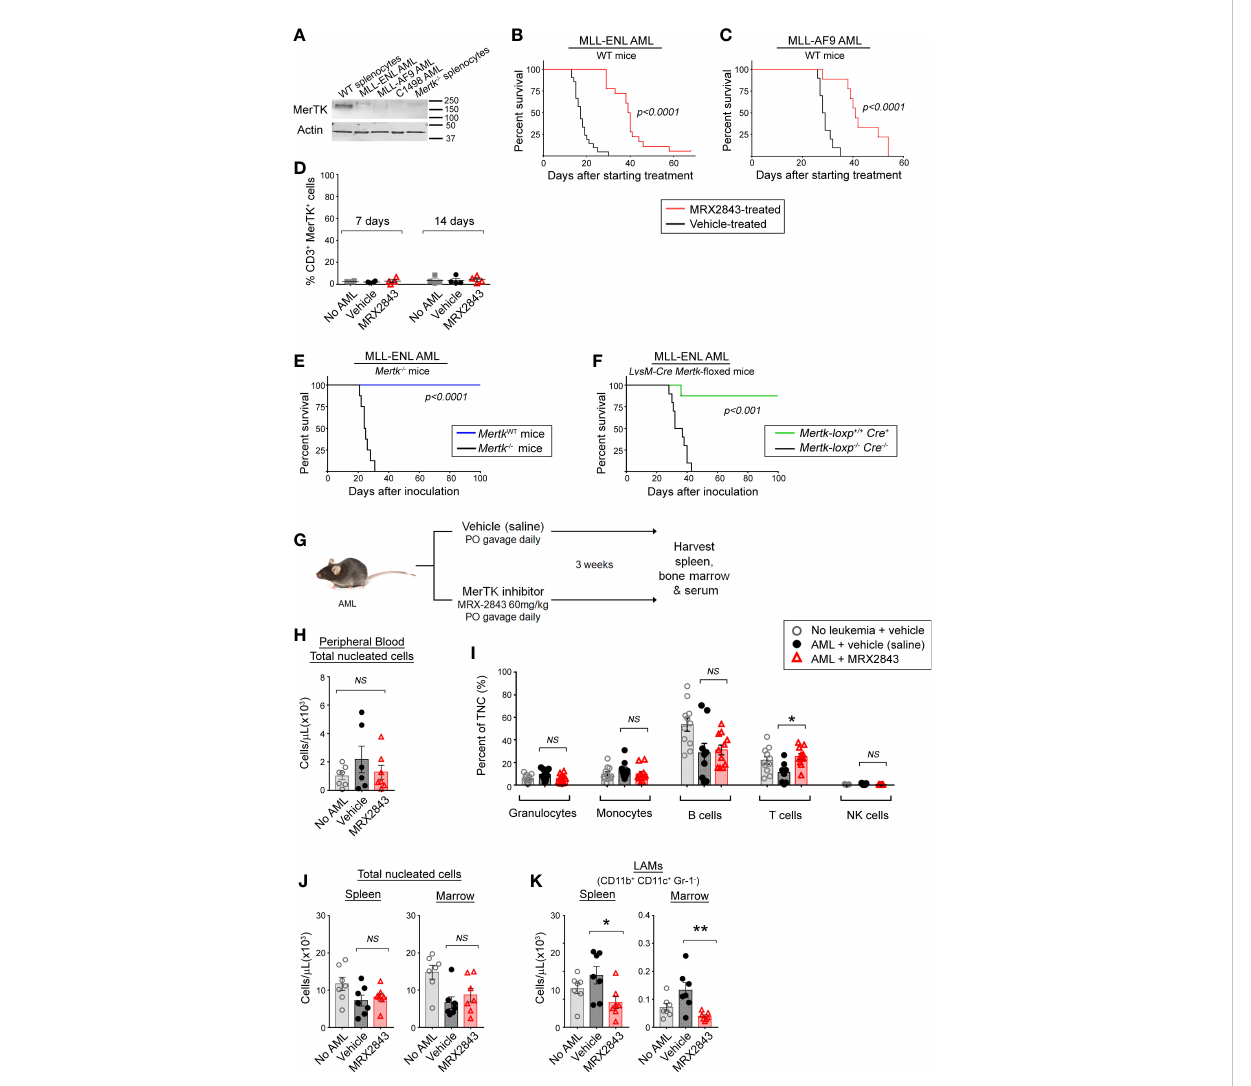
FIGURE 1 Inhibition of MerTK on leukemia-associated macrophages increases survival in syngeneic murine models of AML. (A) MerTK expression in murine AML cell lines was determined by immunoblot. Splenocytes from a Mertk wild-type (WT splenocytes) and Mertk -null ( Mertk -/- splenocytes) mouse were used as positive and negative controls, respectively. Actin is shown as a loading control. (B, C) Syngeneic AML cells were inoculated into C57BL/6 mice by tail vein injection. After three days, mice began daily treatment with MerTK inhibitor MRX2843 (60mg/kg; red line) or an equivalent volume of vehicle (saline; black line). (B) Mice inoculated with 1x10 5 MLL-ENL cells (vehicle n =21, MRX2843 n =18; three independent replicates). (C) Mice inoculated with 1x10 5 MLL-AF9 cells (vehicle n = 10, MRX2943 n = 9; two independent replicates). (D) Peripheral blood T cells collected from mice 7 days and 14 days after starting treatment was analyzed by fl ow cytometry for MerTK expression on CD3 + T cells. (E) 1x10 5 MLL-ENL AML cells were inoculated into Mertk -/- mice (blue line) or littermate wild-type controls ( MerTK WT ; black line) by tail vein injection ( MerTK WT n =7, Mertk -/- n =8; two independent replicates). (F) MLL-ENL AML cells were inoculated into mice by tail vein injection after genotype con fi rmation of MerTK knock-down in dual MerTK and LysM expressing macrophages (i.e. Mertk-loxp +/+ Cre +/- or +/+ , n = 19). Control littermate mice ( Mertk-loxp -/- Cre -/- , n = 19) did not have MerTK knockdown (two independent replicates). (B – F) Weight loss and health score were monitored as surrogates for disease burden; Kaplan-Meier survival analysis measured leukemia-free survival. Analyzed using log-rank test, comparing MerTK inhibited (MRX2843, Mertk -/- , Mertk-loxp +/+ Cre + ) to controls (vehicle, MerTK WT , Mertk-loxp -/- Cre -/- ). (G) Diagram of the murine model used for fl ow cytometric evaluation in this manuscript. (H-K) C57BL/6 mice inoculated with MLL-ENL AML and treated daily with MerTK inhibitor MRX2843 (red triangles) or vehicle (saline; black circles); mice not inoculated with leukemia were used as a control (open gray circles). (H) Peripheral blood total viable nucleated white blood cell count was quanti fi ed by trypan blue exclusion, and (I) percentages of granulocytes, monocytes, B cells, T cells, and NK cells were quanti fi ed by fl ow cytometric analysis. (J) Total viable nucleated cell counts of the spleen and bone marrow were quanti fi ed by trypan blue exclusion. (K) Harvested cells were assessed by fl ow cytometric analysis, and leukemia-associated macrophages (LAMs) within the spleen and marrow were quanti fi ed. Analyzed using 1-way ANOVA. (*p<0.05, **p<0.01, NS, not signi fi